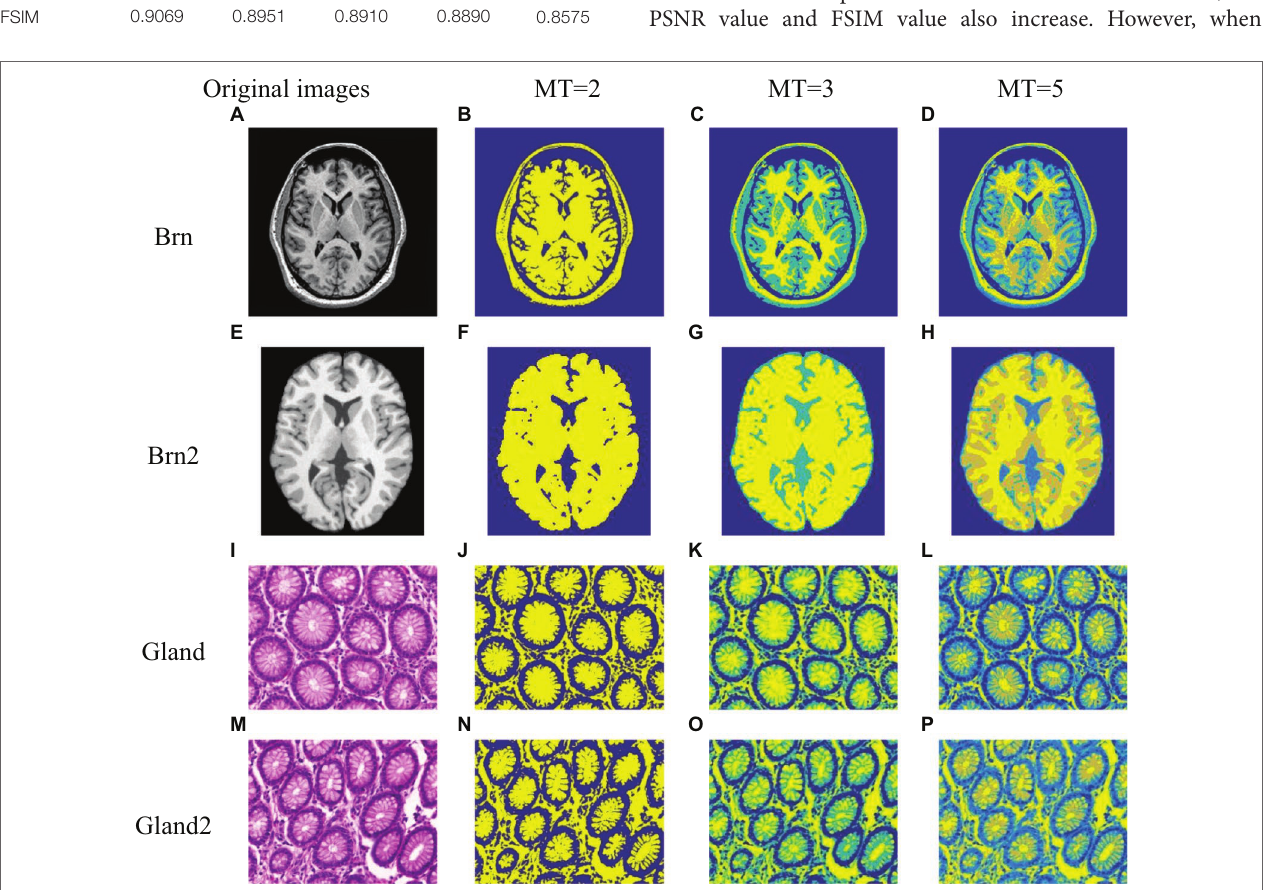
TABLE 2 | Experimental results with different population